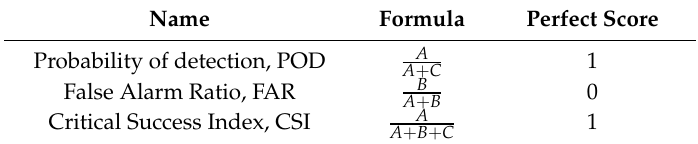
Table 3. Categorical performance measures for comparing station and gridded precipitation